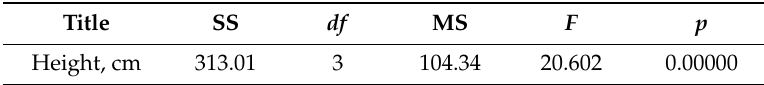
Table 4. Analysis of Variance (One-Way ANOVA) of one-year old container Pinus sylvestris L. seedlings height from different seed-colour classes.